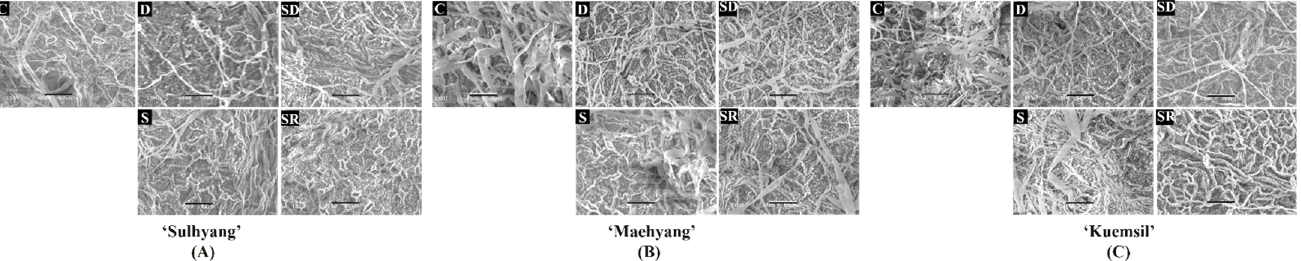
Figure 4. The chlorophyll fluorescence parameters Fv/Fm and Fv/F0 of strawberry ( A ) ‘Sulhyang’; ( B ) ‘Maehyang’; and ( C ) ‘Kuemsil’ as affected by the Si treatments. Lowercase letters indicate sig- nificant differences calculated by the Duncan’s multiple range test at p ≤ 0.05: C, control; S, sprayed “mother” plant; D, drenched “mother” plant; SD, dressed “mother” plant; SR, sprayed “daughter” plant; MP, “mother” plant; and DP, “daughter” plant.